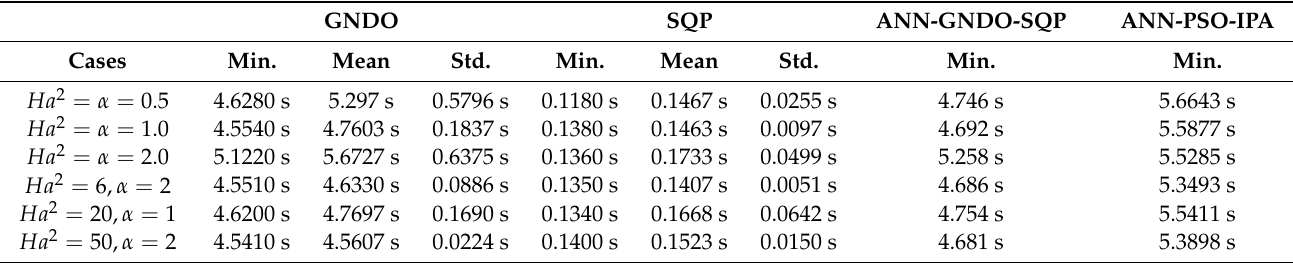
Table 8. Computational complexity analysis of the proposed algorithm for different values of the nonlinearity parameter and Hartmann electric number. GNDO SQP ANN-GNDO-SQP ANN-PSO-IPA